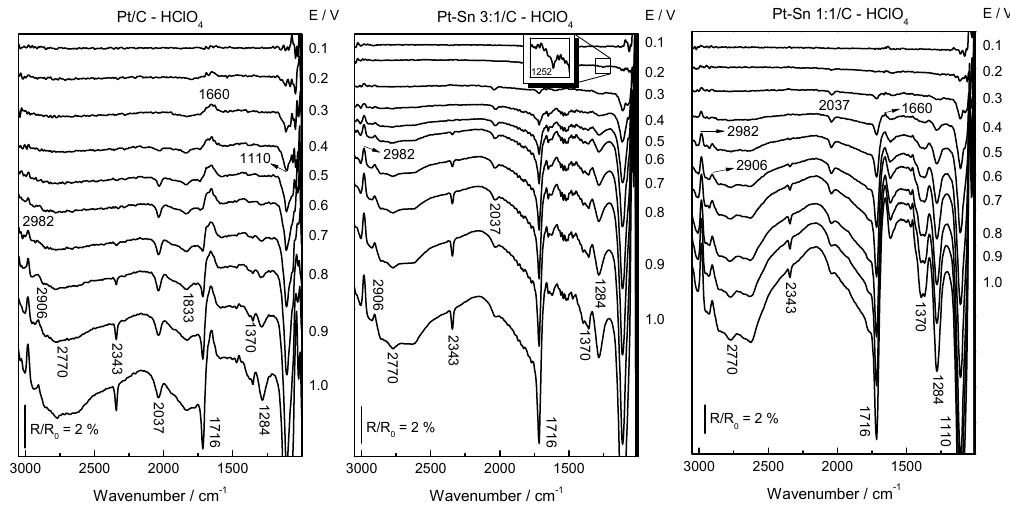
Figure 5. In situ FTIR spectra recorded during the ethanol electrooxidation on Pt/C, Pt–Sn 3:1/C and Pt–Sn 1:1/C catalysts in 1 M CH 3 CH 2 OH + 0.1 M HClO 4 . R i = R 0 = 0.05 V.